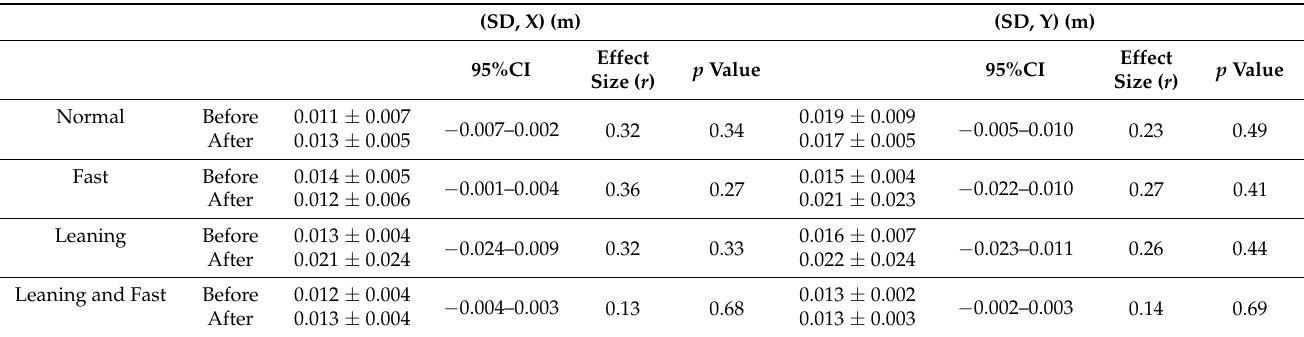
Table 11. Movement variation in the ATG in anterior (SD, Y) and lateral (SD, X) direction of G-foot anterior obstacle crossing.